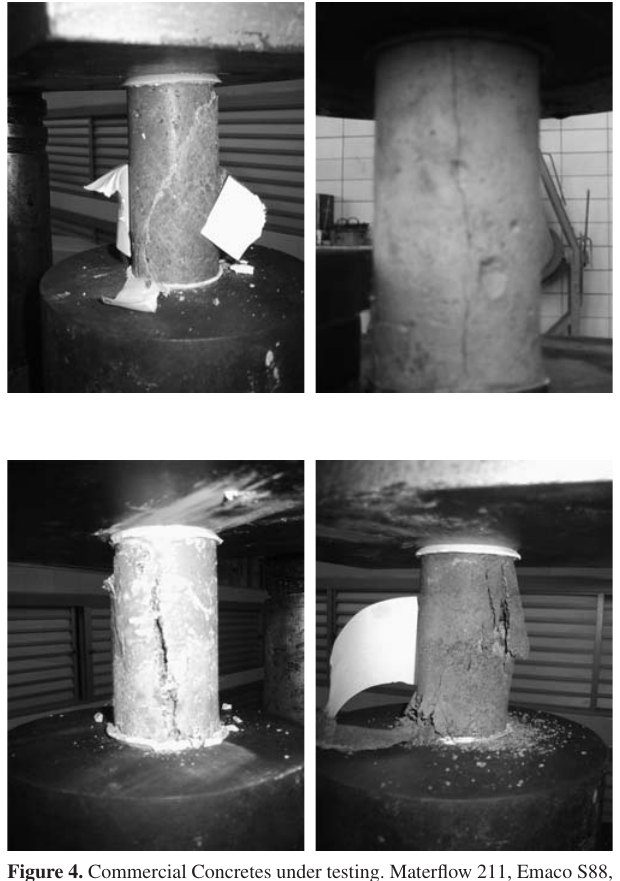
Figure 4. Commercial Concretes under testing. Materflow 211, Emaco S88, GroutekS and HagenPox,